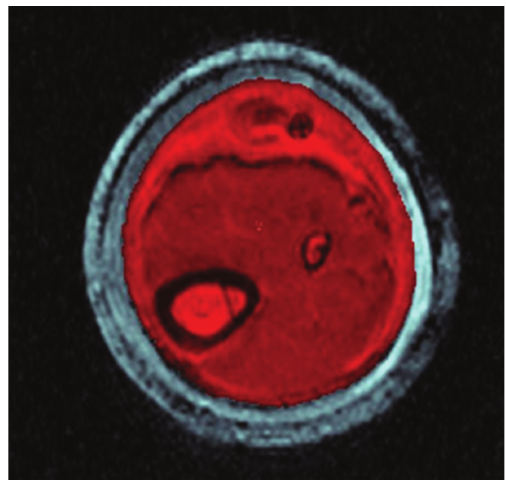
Figure 4: Semiautomatic segmentation of the surface area of test specimen.